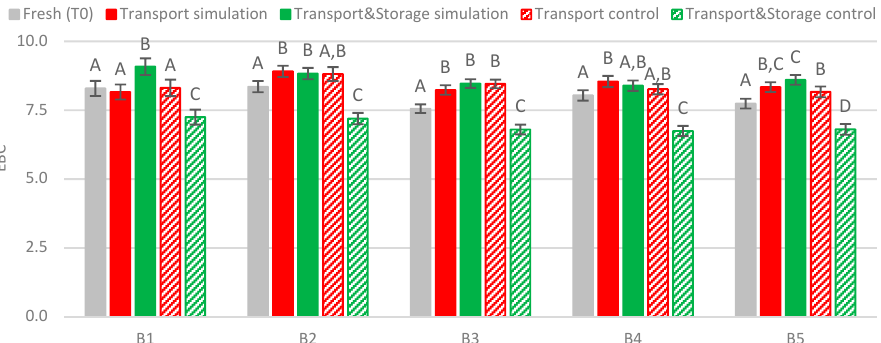
Figure 6. Evolution of beer color under simulated conditions. A Tukey test was performed for each batch. Different letters represent statistically significant differences ( p < 0.05).